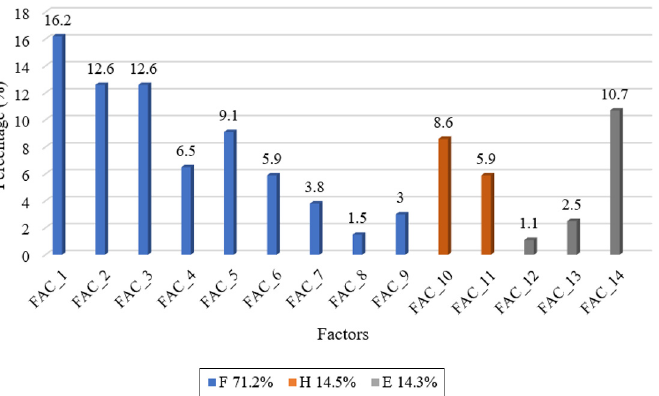
Figure 1. Distribution